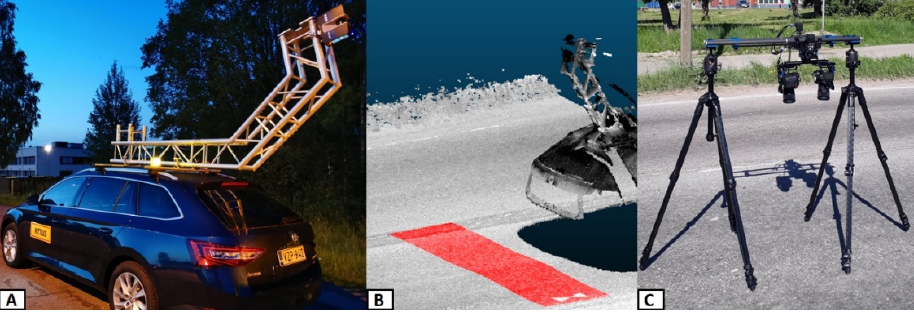
Figure 4. ( A ) Measurement system for TLS. ( B ) TLS point cloud from one measurement. ( C ) Photo- grammetric measurement system. togrammetric measurement